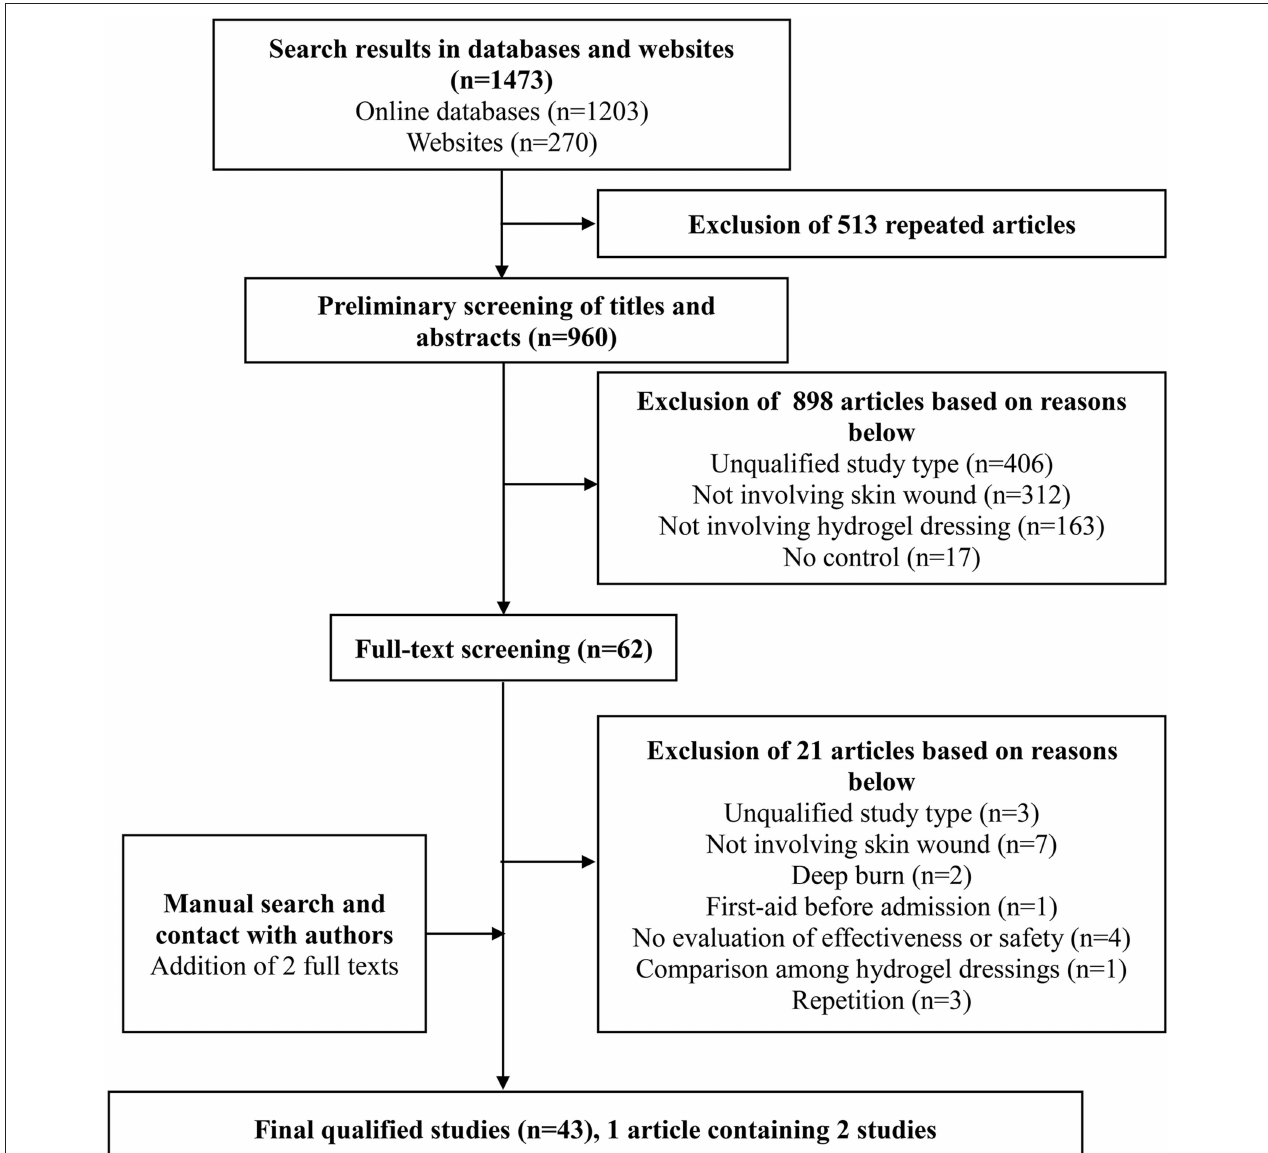
FIGURE 1 | PRISMA flow diagram for inclusion or exclusion of studies used for systematic